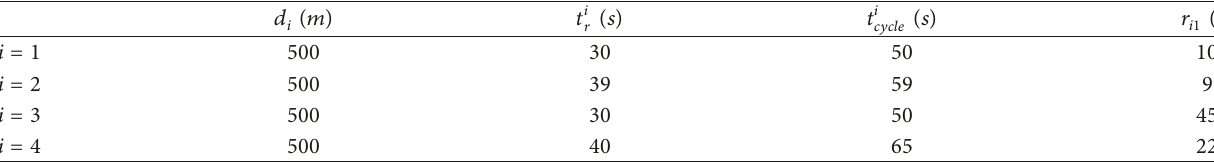
Table 1: Traffic light location and timing information.